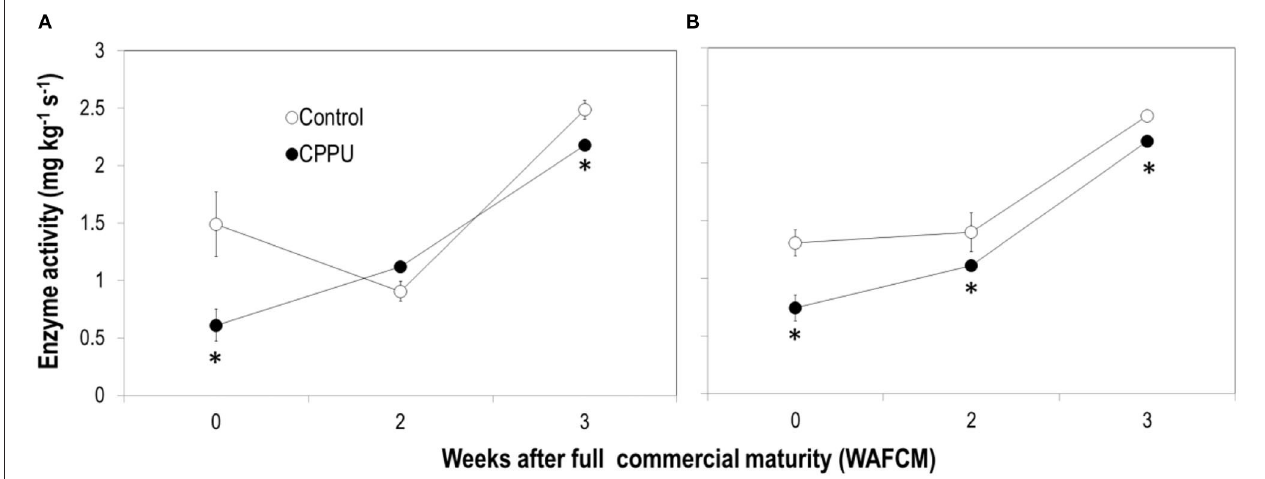
FIGURE 10 | Effects of preharvest application of CPPU on the activities of SNIV (A) and SAIV (B) . Vertical bar at each data point stands for standard error ( n = 5). *Indicates significant difference between CPPU treatment and the control at p < 0.05, Student’s t -test.